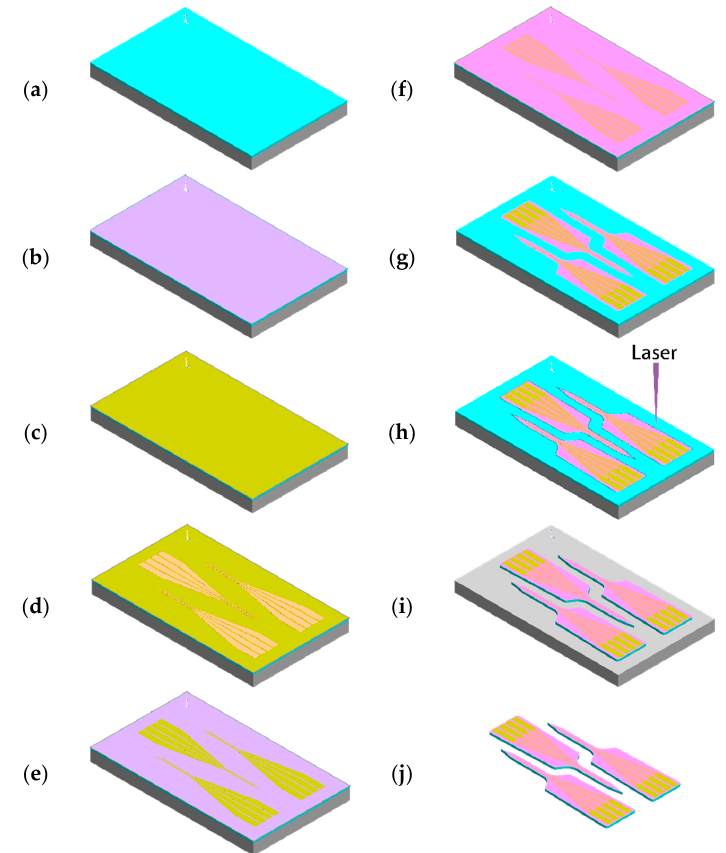
Figure 2. Microfabrication process for PVAc-CNC intracortical probes. ( a ) PVAc-CNC film mounted to bare Si probe; ( b ) Parylene C deposition; ( c ) Ti/Au deposition; ( d ) Photoresist spin-coating and patterning; ( e ) Wet etching of Ti/Au films; ( f ) Second Parylene C deposition; ( g ) Parylene C patterned using oxygen plasma; ( h ) Laser micromachining the PVAc-CNC substrate; ( i ) Remove excess PVAc-CNC in field region; ( j ) Release probes.